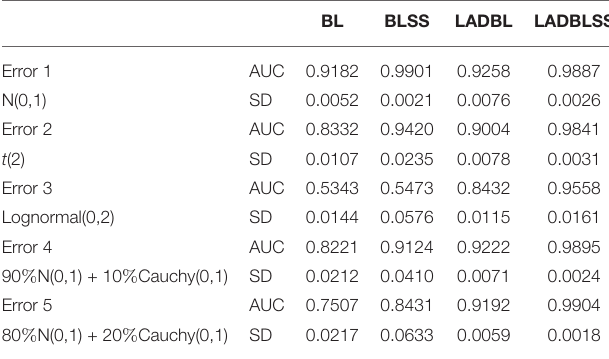
TABLE 1 | Simulation results of the first setting for BL (Bayesian LASSO), BLSS (Bayesian LASSO with spike-and-slab priors), LADBL (LAD Bayesian LASSO), and LADBLSS (LAD Bayesian LASSO with spike-and-slab